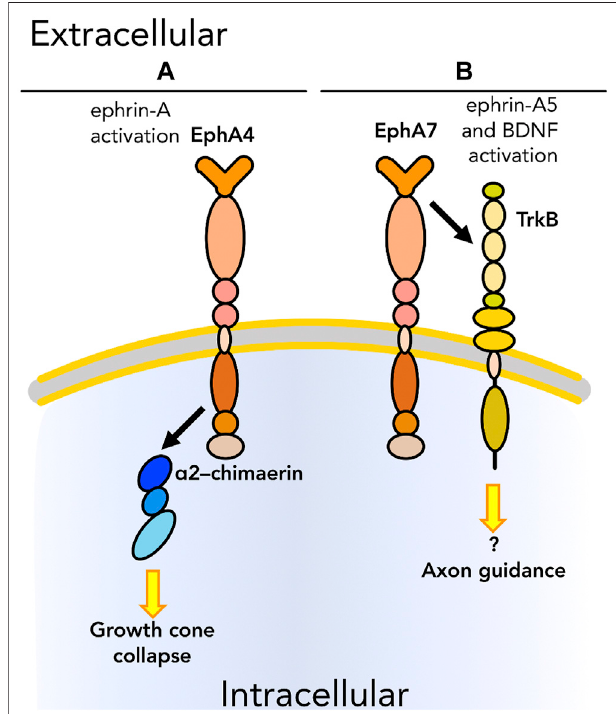
FIGURE 4 | Graphical representation of cis physical interactions occurring between Ephs and other molecules to promote or inhibit the ability of cells to “ read ” the surrounding environment: cell sensing. (A) EphA4 interacts with α 2 – chimaerin, that results in growth cone collapse. (B) EphA7 regulates axon guidance by interacting with TrkB upon, respectively, ephrin-A5 and BDNF binding. As we know only some of the downstream pathways, unknown downstream effectors are listed with a question mark. Receptors are depicted as single chains for simplicity. References are listed